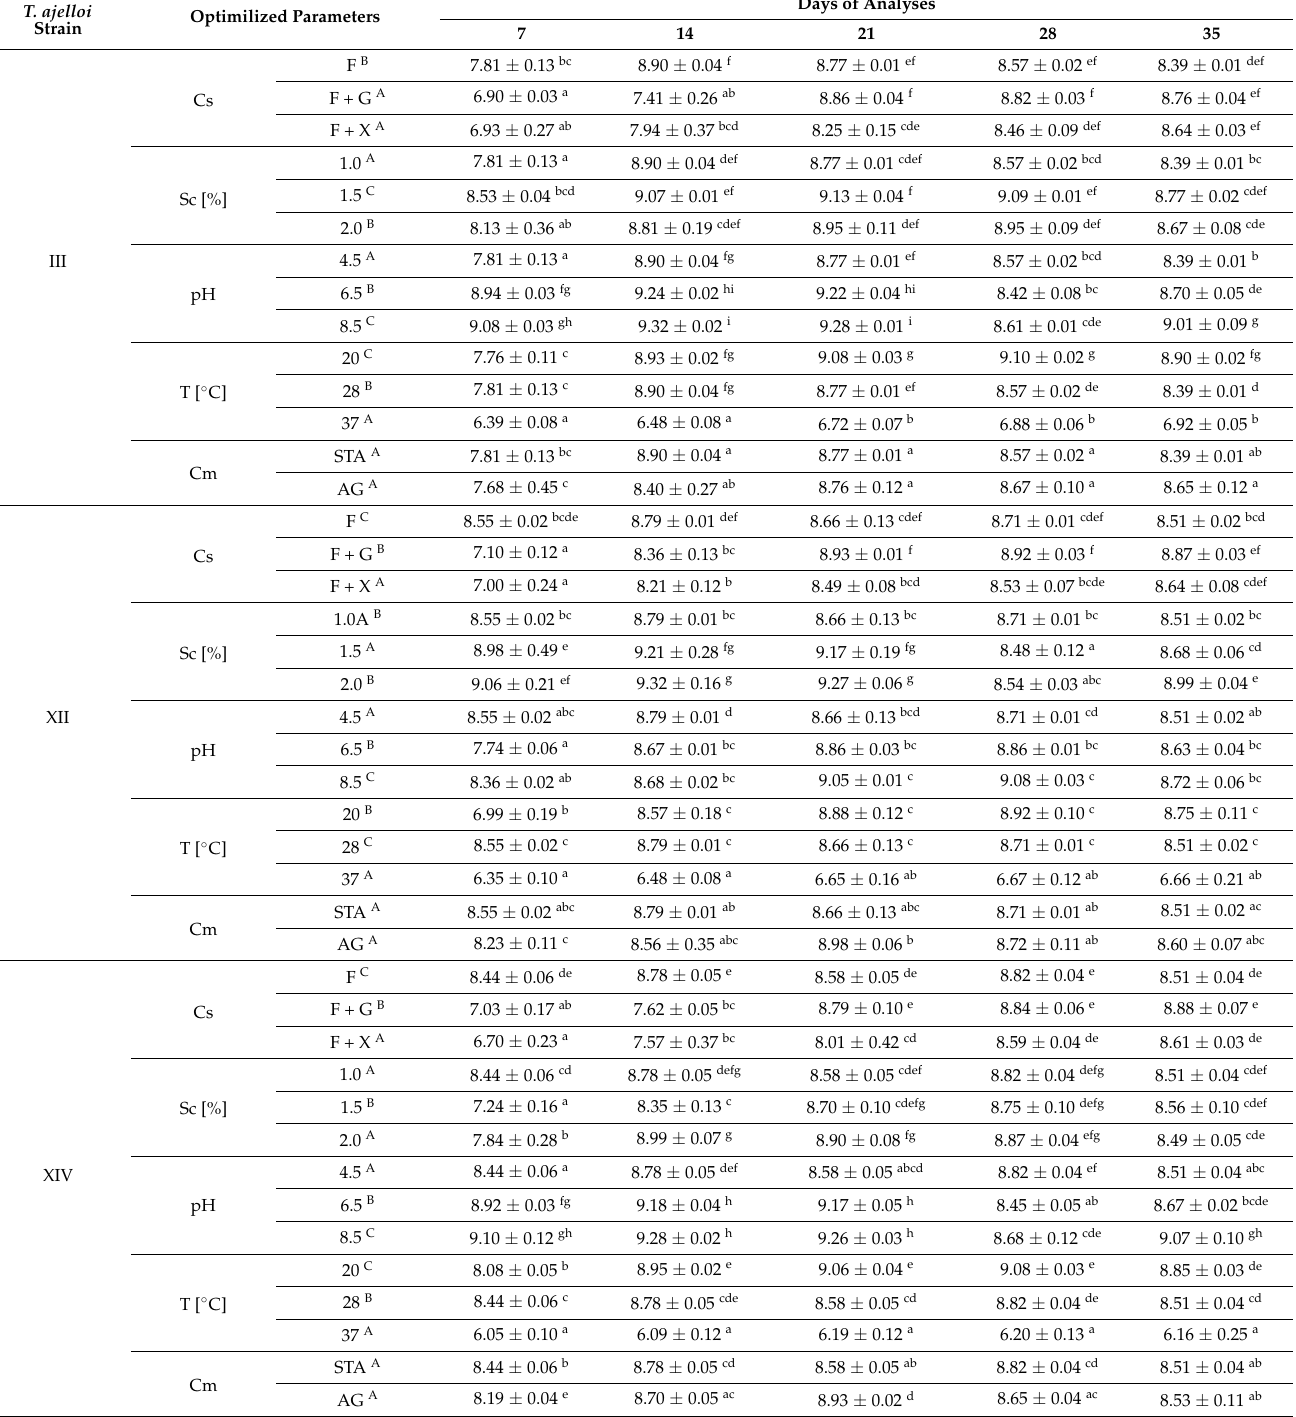
Table 3. Dynamics of pH changes in Trichophyton ajelloi culture medium under different culture conditions and medium